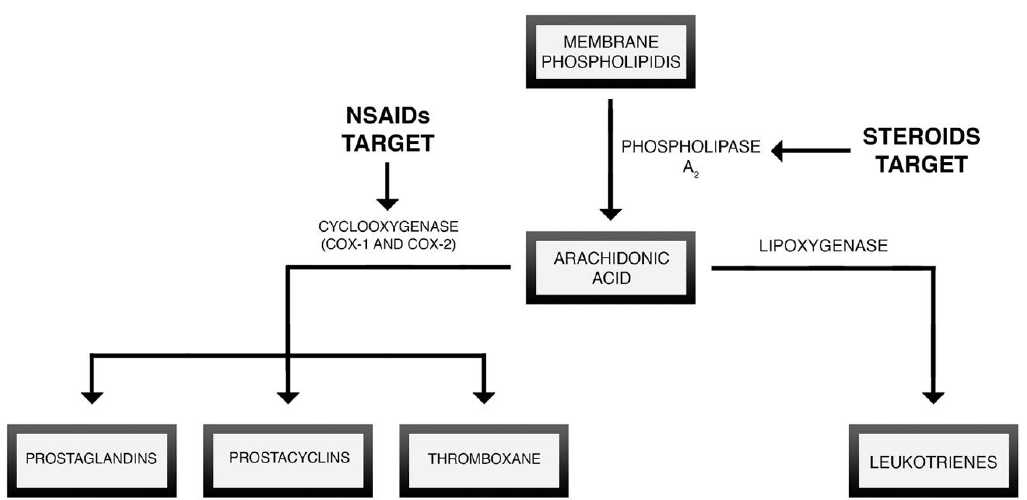
Figure 3. Initial stage of the cascade is mediated by phospholipase A2, whose activity leads to the release of arachidonic acid from membrane phospholipids. Arachidonic acid can be further